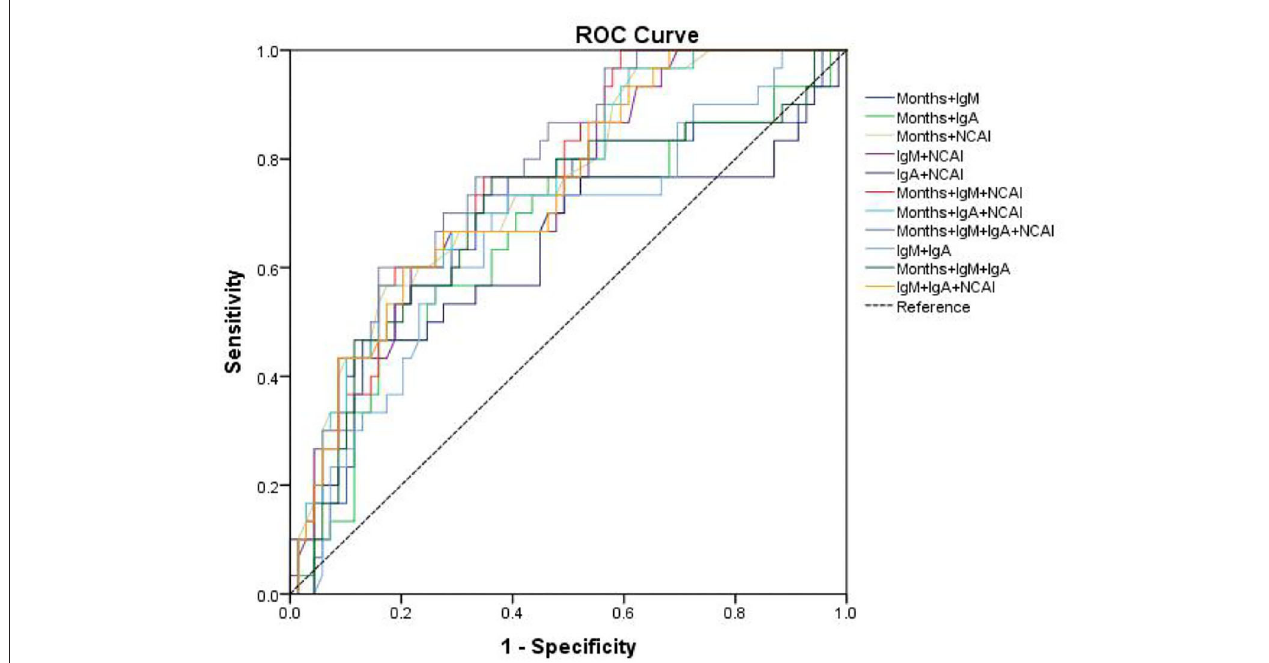
FIGURE 4 | The ROC curve of age, IgM, IgA and NCAI combined prediction of